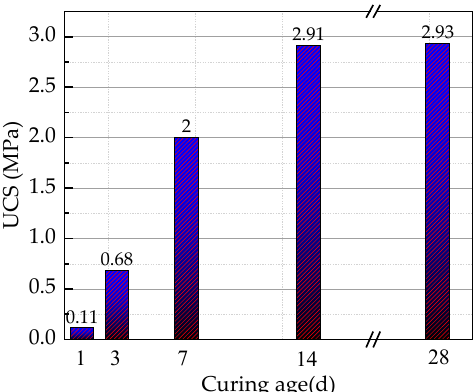
Figure 5. Diagram for the changes in the UCS of cemented paste backfill (CPB) with curing age.